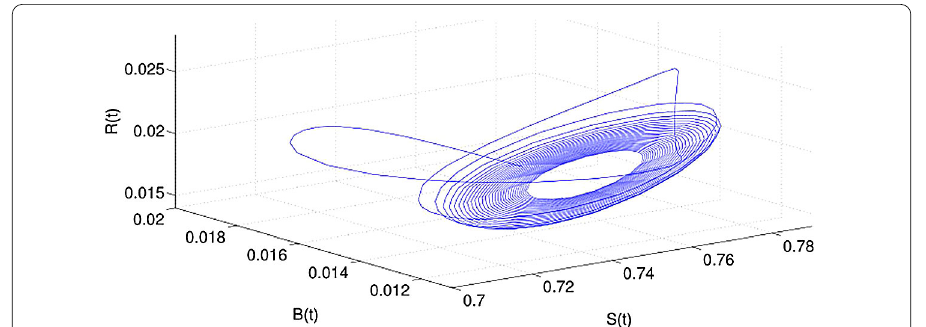
Figure 4 Dynamic behavior of system (41): projection on S-B-R with τ 2 = 68.4658